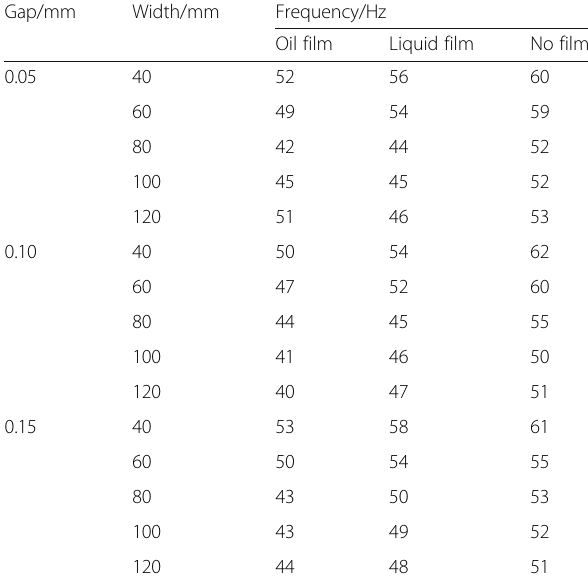
Table 5 Cutting, liquid film, and oil film influence on the spindle amplitude